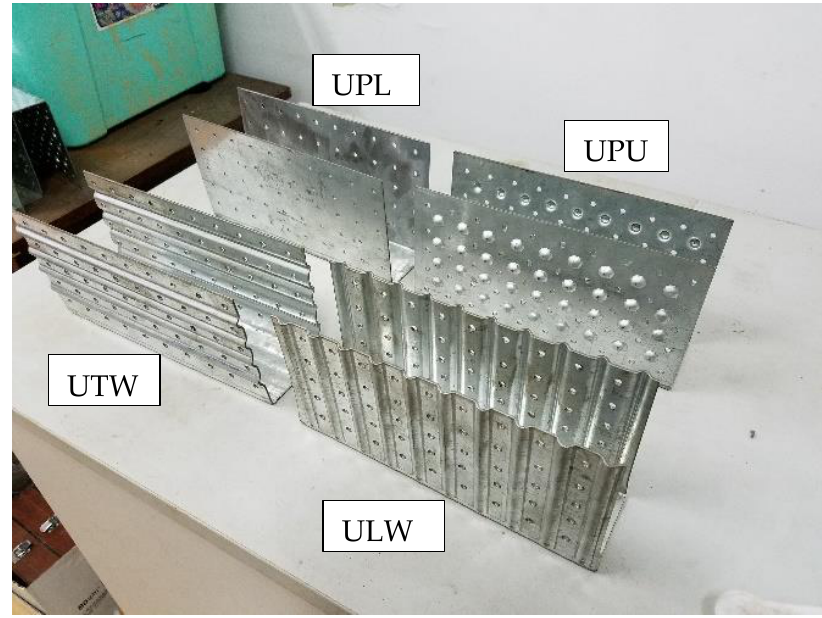
Figure 2. Four types of U-shape connector used.